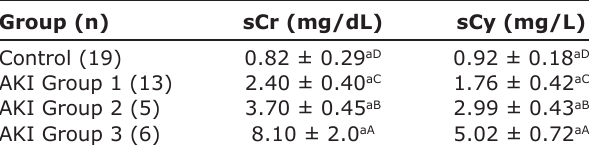
compare columns and lowercase letters are used to compare lines. Values with different letters indicate a statistically significant difference (p < 0.05). Group 1: sCr between 1.7 and 3.0 mg/dL. Group 2: sCr between 3.1 and 5.0 mg/dL. Group 3: sCr > 5.0 mg/dL. Reference values: sCr < 1.6 mg/dL and sCy < 1.29 mg/L